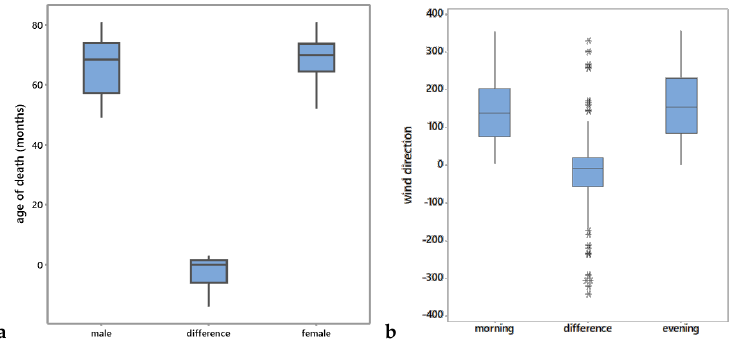
Figure 1. Boxplots for selected publicly available data. Left ( a ): R Project twins dataset results. Right ( b ): Results for Table 13.1 from Andrews and Herzberg [17].